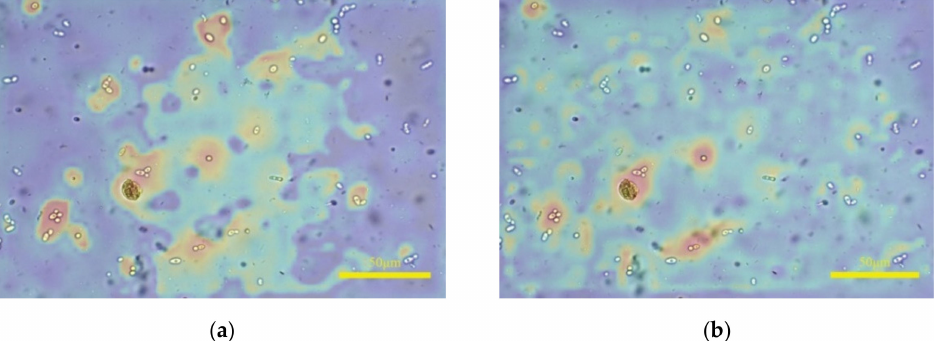
Figure 8. The attention heat maps of fecal microscopic image visualized by Grad-CAM++. ( a , b ) presents the attentions in the output of Layer5 of L0 and L1,